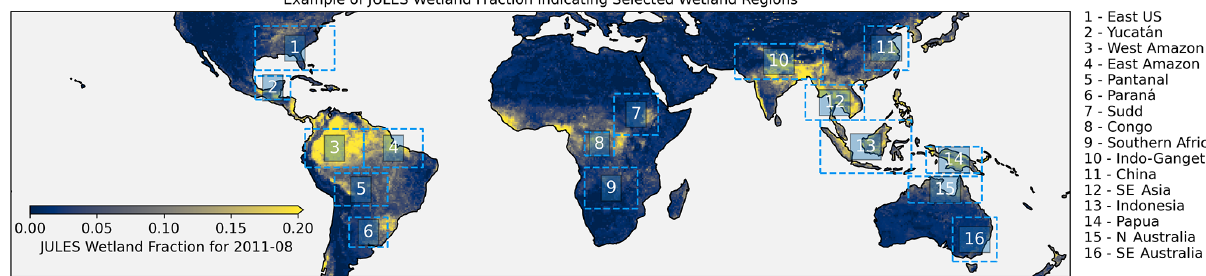
Figure 3. Map showing the locations of the 16 wetland regions considered in this study. A representative month (August 2011) of the JULES wetland fraction is shown as the